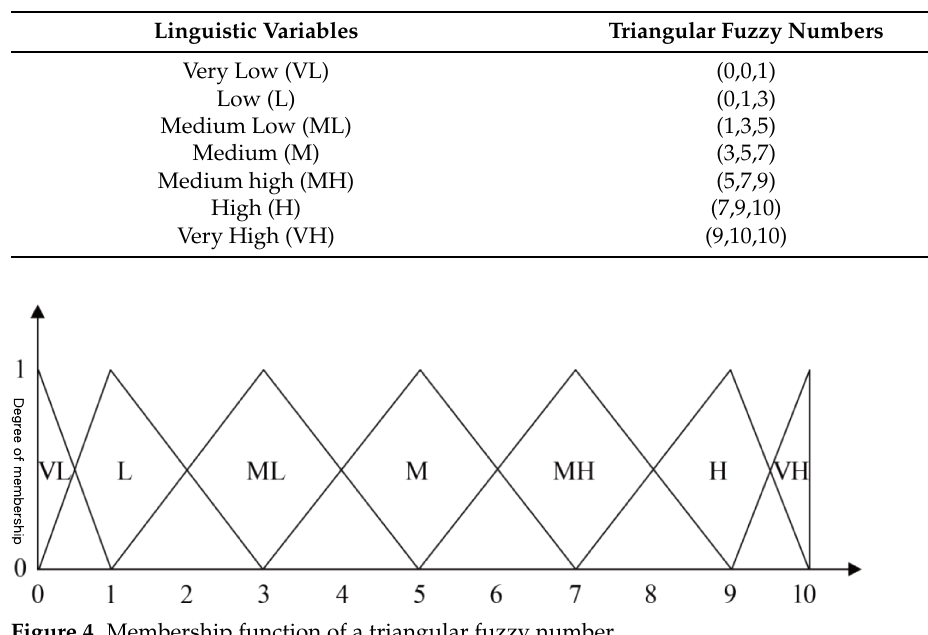
Table 2. Linguistic variables for the importance and the ratings.